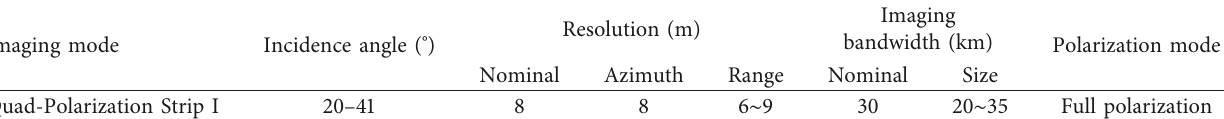
Table 2: Main technical specifications of each imaging